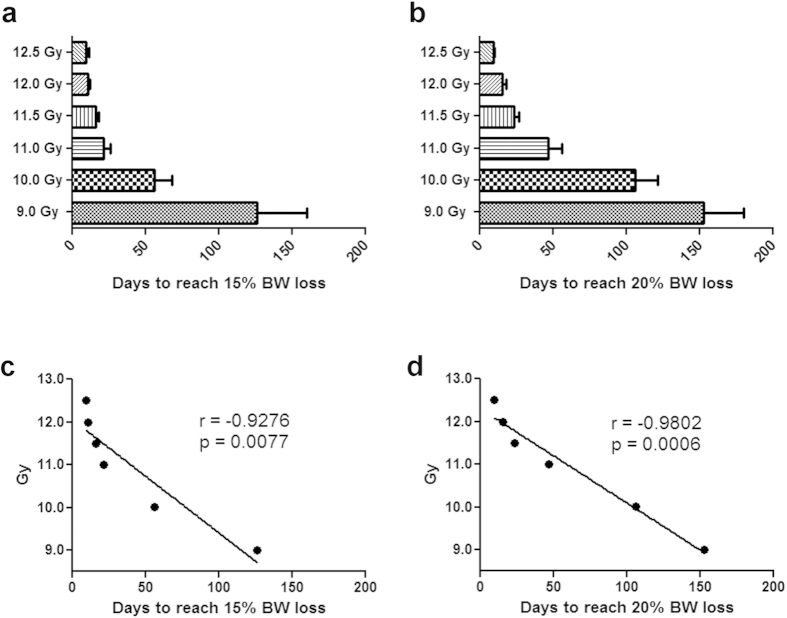
Time to reach 15% or 20% body weight loss at different radiation doses.The time (in days, mean ± s.e.m.) to reach 15% (a) or 20% (b) body weight loss was plotted for each radiation dose cohort (same animals from Fig. 1). The correlation of the time to reach 15% body weight loss (c) or 20% body weight loss (d) to radiation doses was plotted. For NHP survived 180 days and didn’t lose 15% or 20% body weight, the time was imputed with 180 because the study was only 180 days. This approach may underestimate the time to reach 15% or 20% body weight loss particularly in the lower radiation dose cohorts.